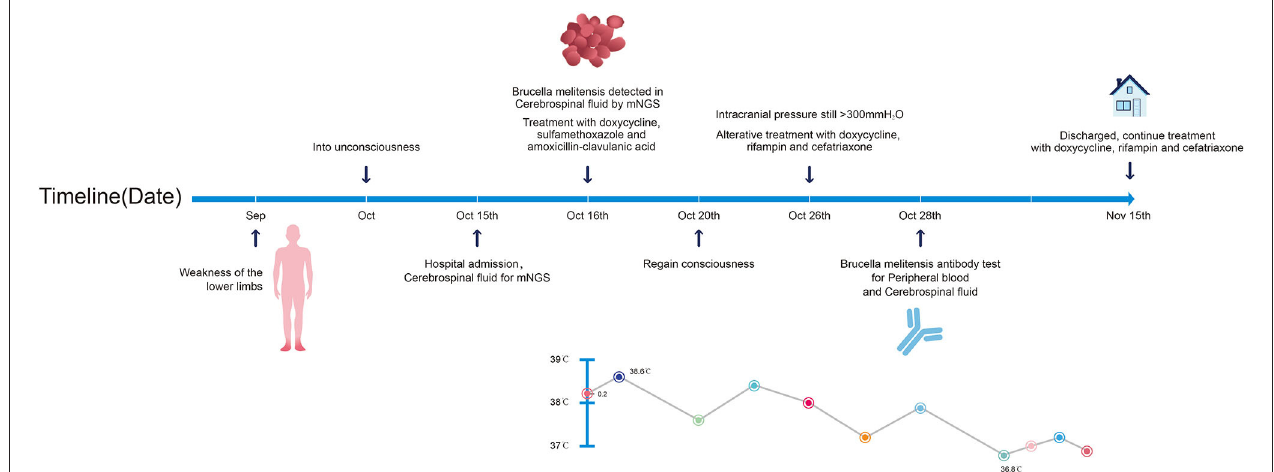
FIGURE 2 | Timeline of the case